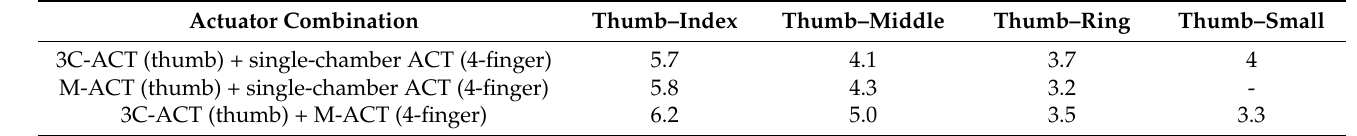
Table 2. The pinch force of the 3-chamber actuator and modular actuator